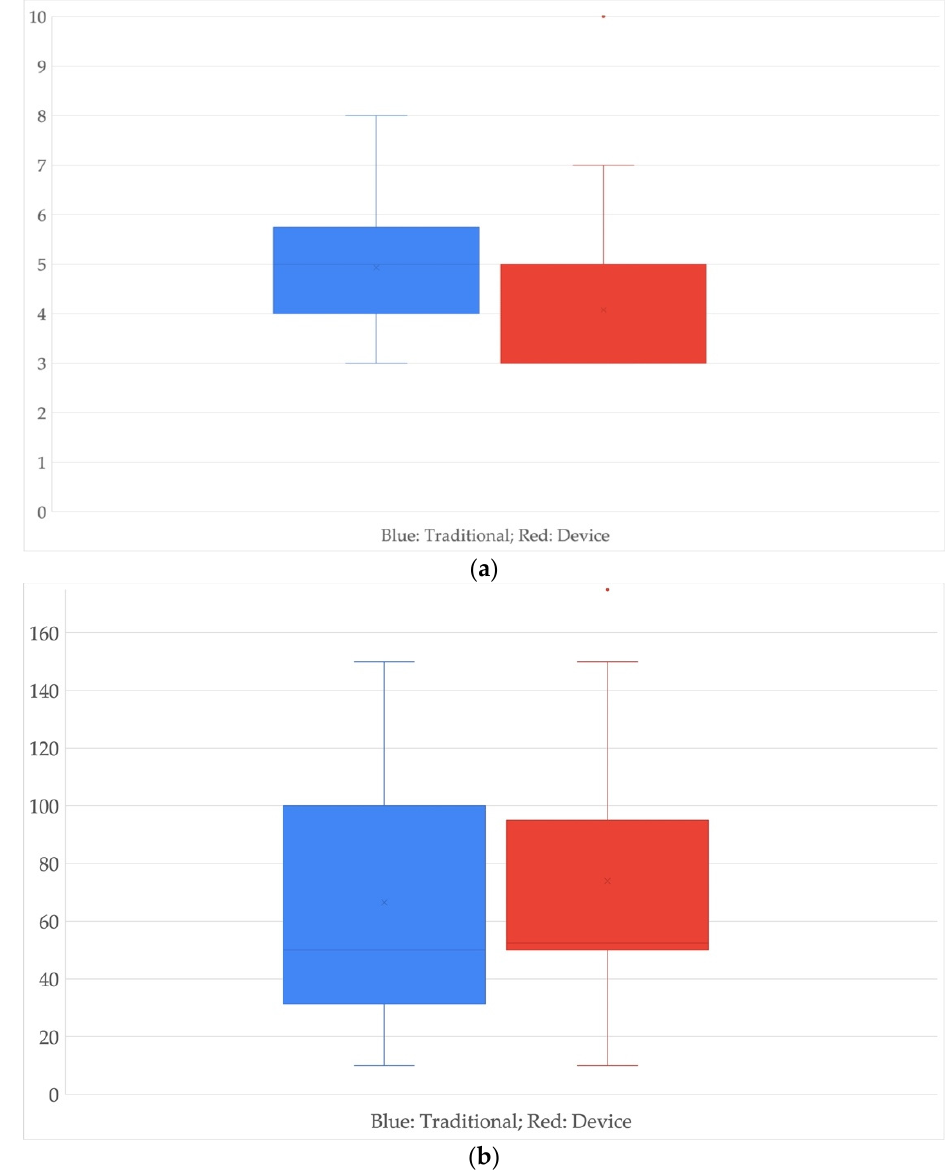
Figure 2. Boxplot to compare ( a ) LOS “Traditional vs. Device” (y axis unit: days), ( b ) drain output “Traditional vs. Device” (y axis unit: c.c.).